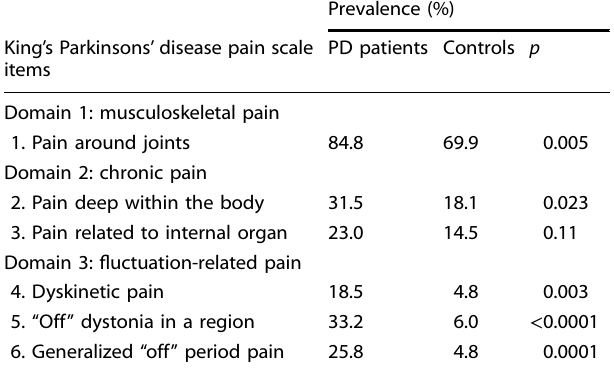
Table 2. Types of pain prevalence in the